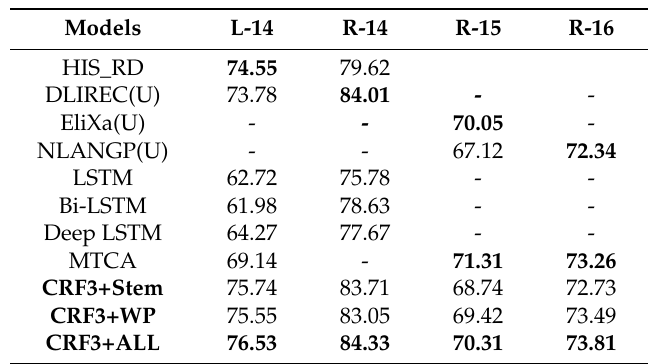
Table 5. Comparison in F1 on SemEval2014, 2015 and 2016